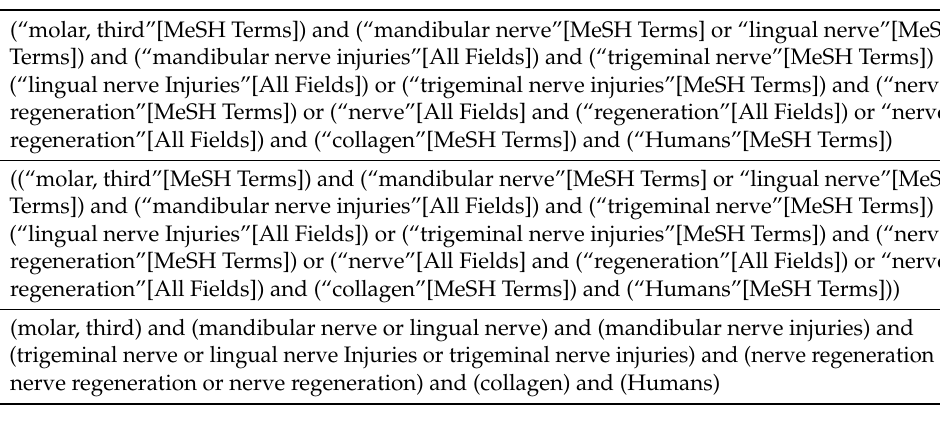
Table 1. Search Strategy (PubMed, Web of Science (WOS) and Cochrane Central Register of Controlled Trials (CENTRAL).